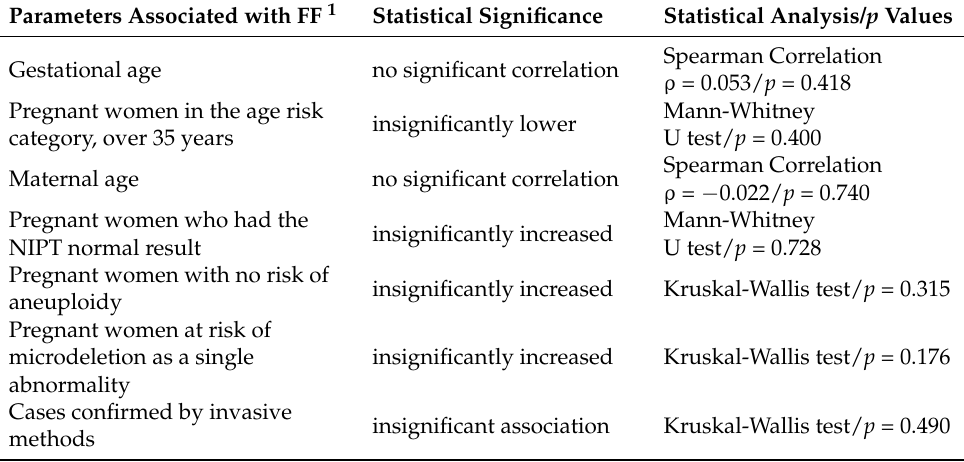
Table 2. Associations between fetal fraction and different parameters.